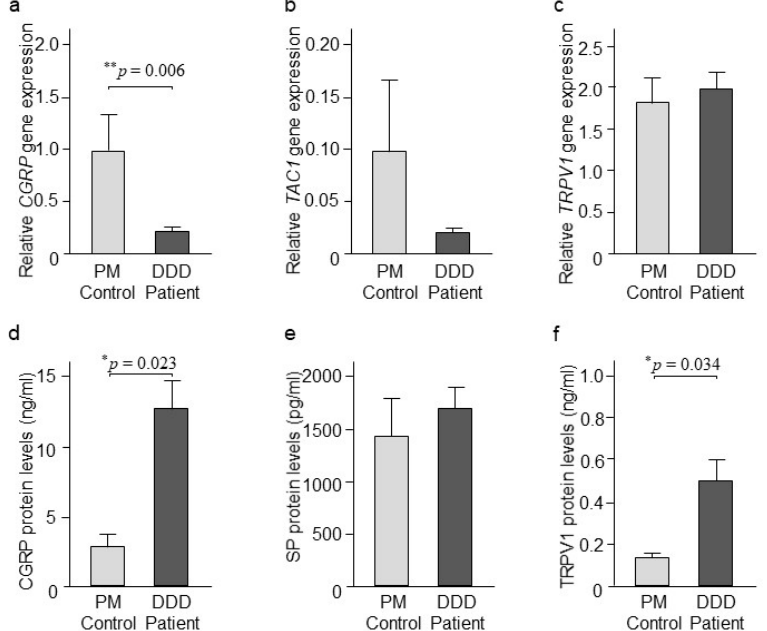
Figure 3. CGRP, SP, and TRPV1 expression. ( a ) Relative gene expression of CGRP ( n = 23 DDD patients and 14 PM control), ( b ) TAC1 ( n = 33 DDD patients and 16 PM control), and ( c ) TRPV1 ( n = 33 DDD patients and 17 PM control) in intervertebral disc (IVD) tissues retrieved from DDD patients and PM controls. Values reported are mean ± SEM. ** p ≤ 0.01, comparison between DDD patients and PM controls calculated by Student’s t -test. ( d ) Protein levels of CGRP ( n = 30 DDD patients and 7 PM control), ( e ) SP (n = 25 DDD patients and 9 PM control), and ( f ) TRPV1 ( n = 28 DDD patients and 9 PM control) in cytosolic extracts retrieved from IVD tissues from DDD patients and PM controls. Values reported are mean ± SEM. * p ≤ 0.05, comparison between DDD patients and PM controls calculated by Student’s t -test.